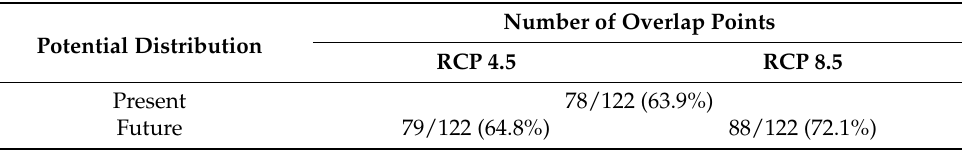
Table 3. The number of overlapping points with the distribution of the Hyla Suweonensis according to the change in the distribution of Lithobates catesbeianus